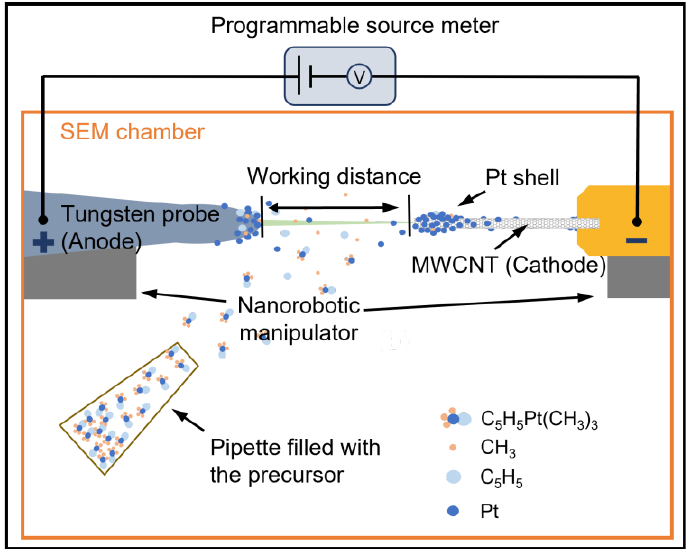
Figure 3. Diagram of the setup for the FE test and in situ growth of the Pt shell inside an SEM.